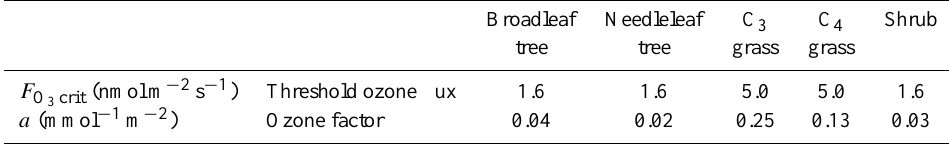
Table 4. Default values of PFT-specific parameters for ozone effects. The values for a are the low sensitivity values from Sitch et al. (2007). Broadleaf Needleleaf C 3 C 4 Shrub tree tree